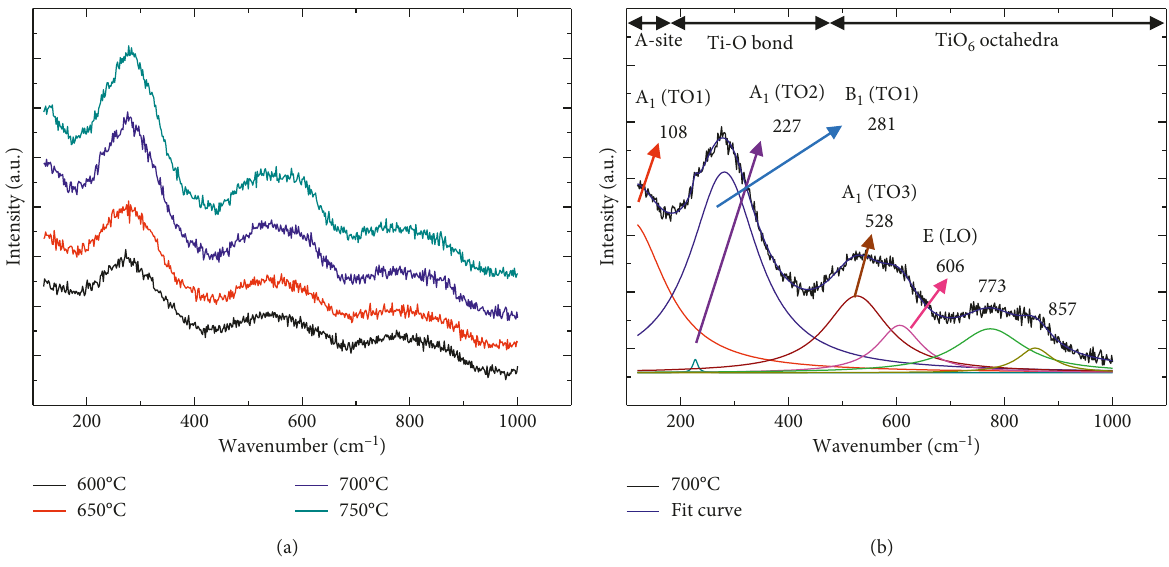
Figure 3: (a) Raman spectra of BNKT films in the wavenumber ranges of 100–1000cm − 1 and (b) fit curve of S700 films.